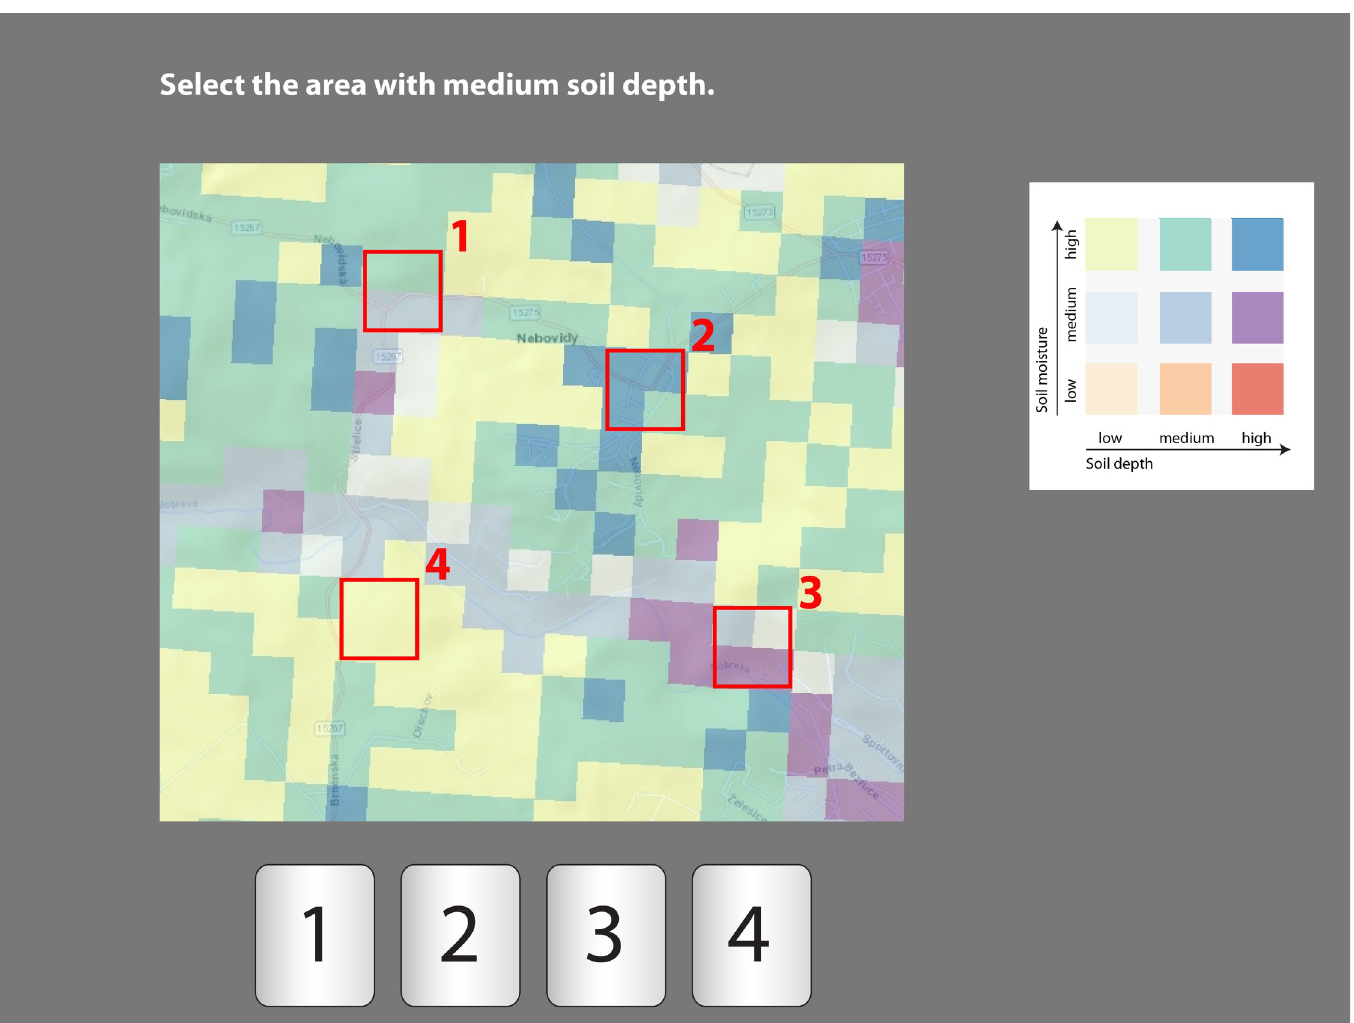
Fig 3. Example of an intrinsic visualization item (subtest A–part A.1.). The task was to select the area which contained “medium soil depth”; the correct answer was area No.